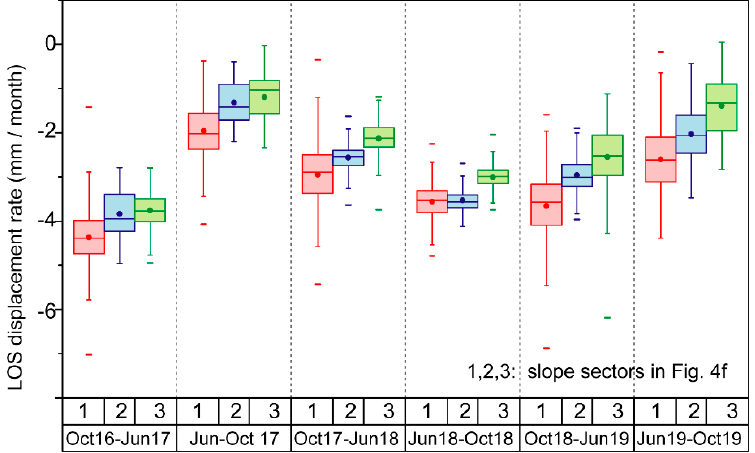
Figure 6. Seasonal response of slope sectors. Distributions of LOS displacement rates extracted from seasonal interferograms (Jun-Oct and Oct-Jun) for the 3 sectors highlighted in Figure 4f. Whisker lengths: upper and lower inner fences based on interquartile range (IQR).